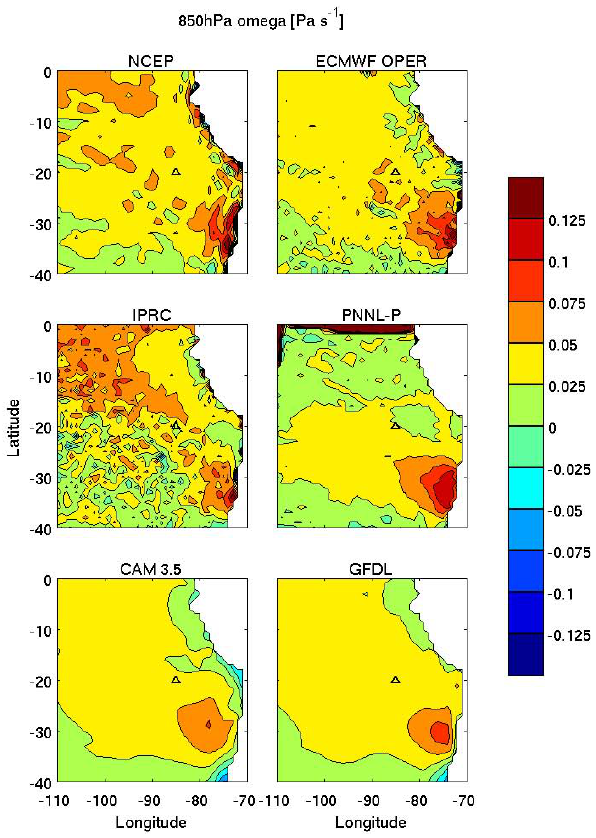
Fig. 3. October 2006 mean subsidence at 850hPa (Pas − 1 ). NCEP and ECMWF analysis is shown in lieu of observed subsidence. The stratus buoy location is indicated with a